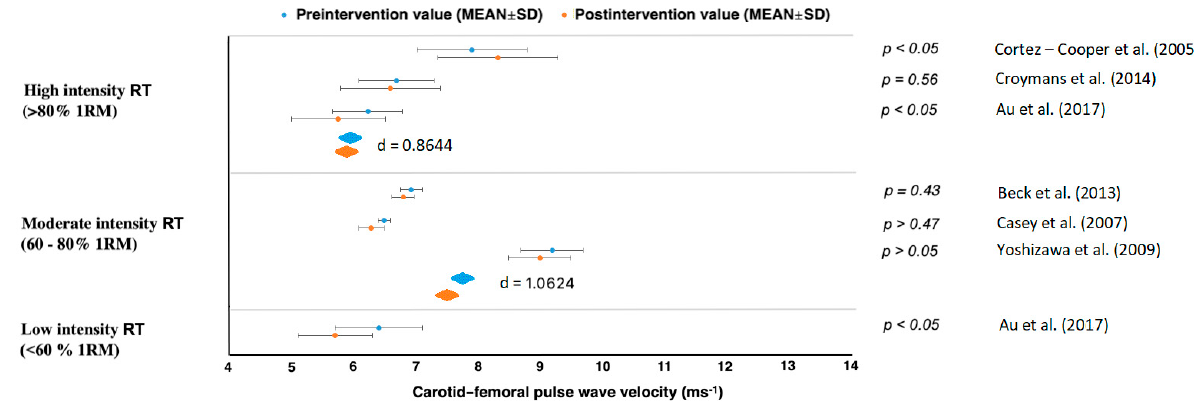
Figure 3. Absolute change score (ms − 1 ) in long-term resistance training programs. a upper limb training group, b lower limb training group, c group of resistance training with slow lifting and quick lowering. baPWV, brachial–ankle pulse wave velocity; caPWV, carotid–femoral pulse wave velocity; faPWV, femoral–ankle pulse wave velocity; RM, repetition maxi- mum. Black diamonds represent the weighted mean and standard error, blue dot is the mean difference with standard deviation.